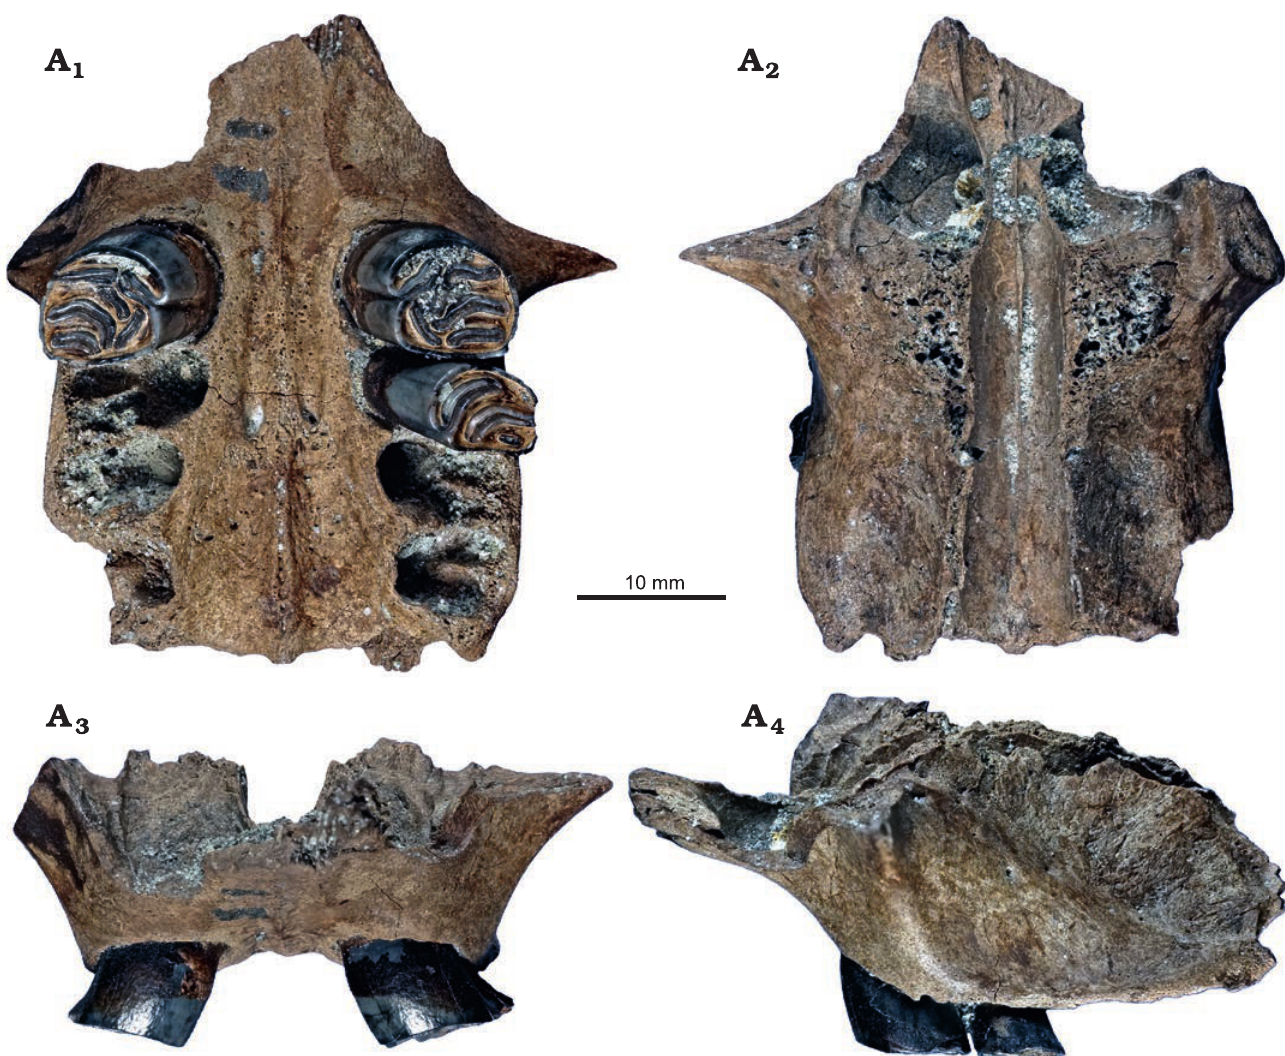
Fig. 2. Maxillae and fragmentary palatine of the beaver Steneofiber depereti Mayet, 1908 (GPIT/MA/17163), from the early Late Miocene loca lity Hammerschmiede (Bavaria, Germany), local stratigraphic level HAM 4. Maxillae and fragmentary palatine with left P4–M1 and right P4 in occlusal (A 1 ), dorsal (A 2 ), mesial (A 3 ), and left buccal (A 4 )